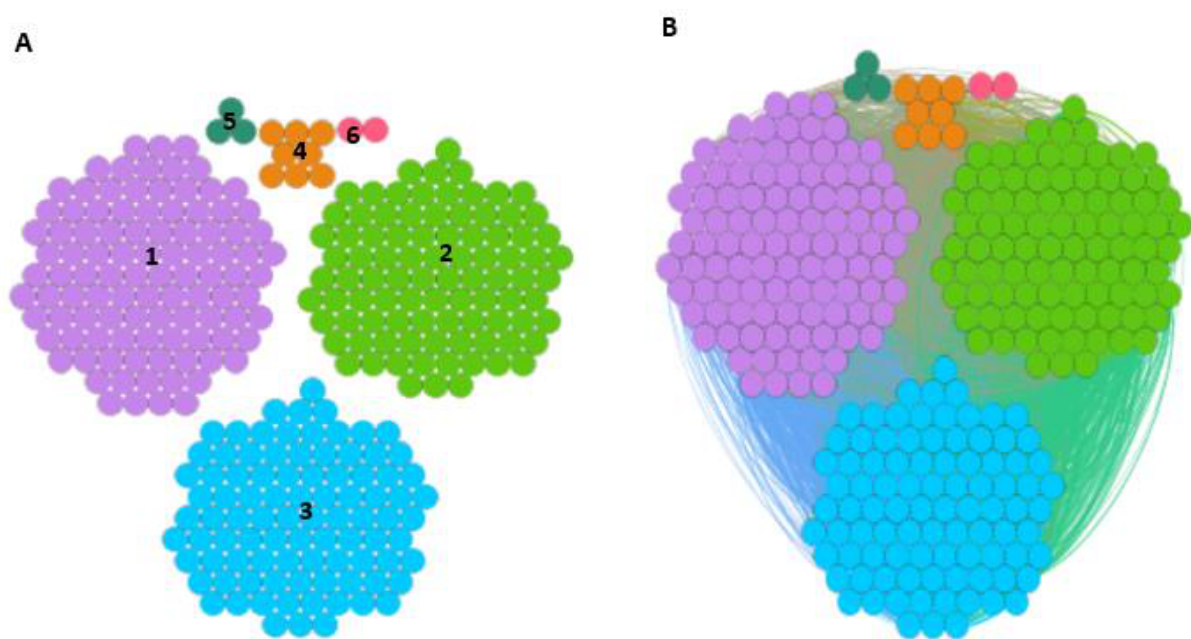
Figure 4. Clustering network for the co-citation analysis (A: without edges; B: with edges). Table 8. Lead papers from each cluster according to their PageRank.